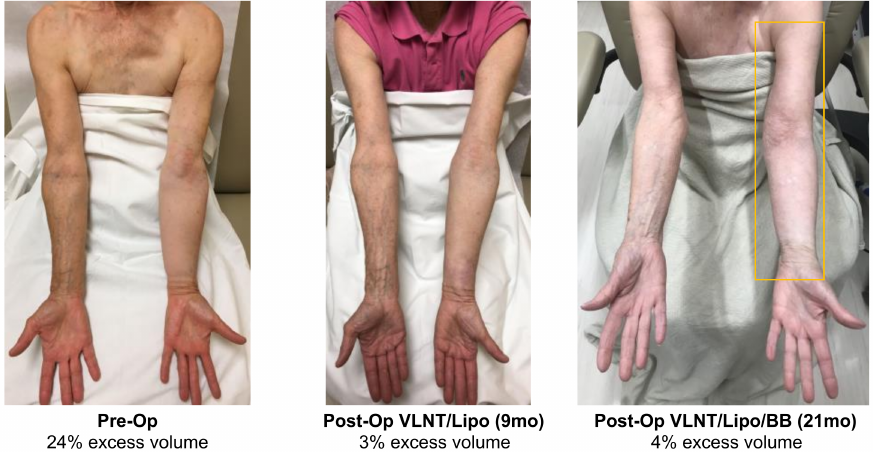
Figure 3. Upper extremity excess volume of 24% reduced to 3% at 9 months following combined VLNT and liposuction. BB was implanted at 12 months post-op resulting in the stabilized volume excess of 4% at 21 months following triple therapy surgical